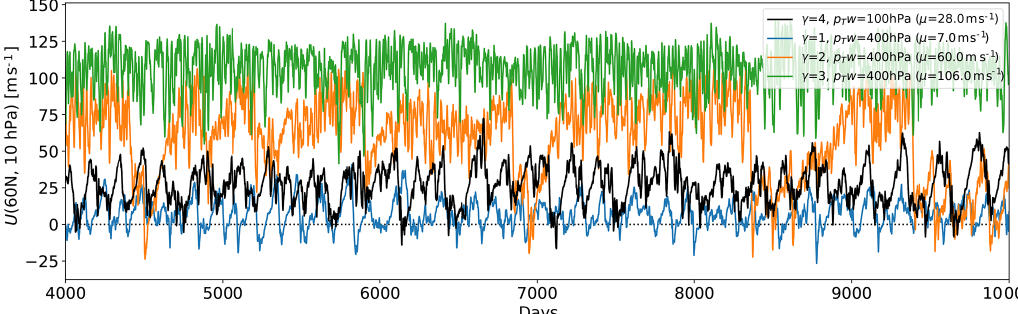
Figure 5. Time series of zonal-mean zonal wind (ms − 1 ) at 10hPa and 60 ◦ N for different configurations of the PK setup with a WN2 topography with h = 3km. The black line displays the reference simulation with γ = 4Kkm − 1 as in Fig. 4b. The colored lines display the sensitivity simulations discussed in Sect. 4.2, with lowered winter transition pressure p Tw and for γ = 1, 2 and 3Kkm − 1 (see legend). In the legend, the average wind speed at this location over the whole simulation is given (denoted µ